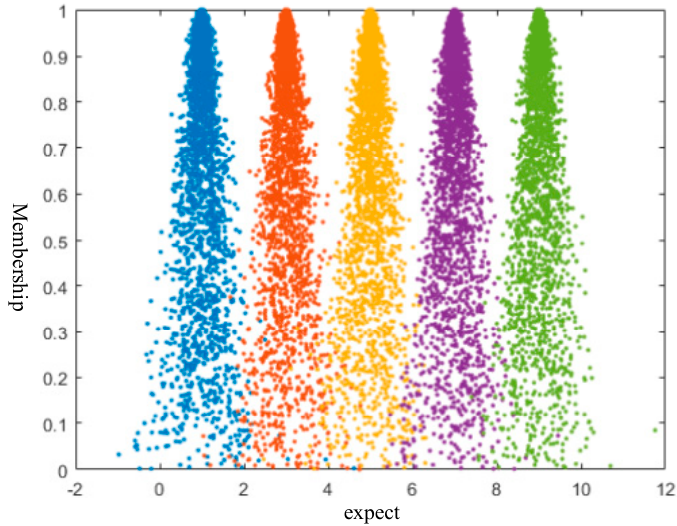
Figure 5. Standard evaluation